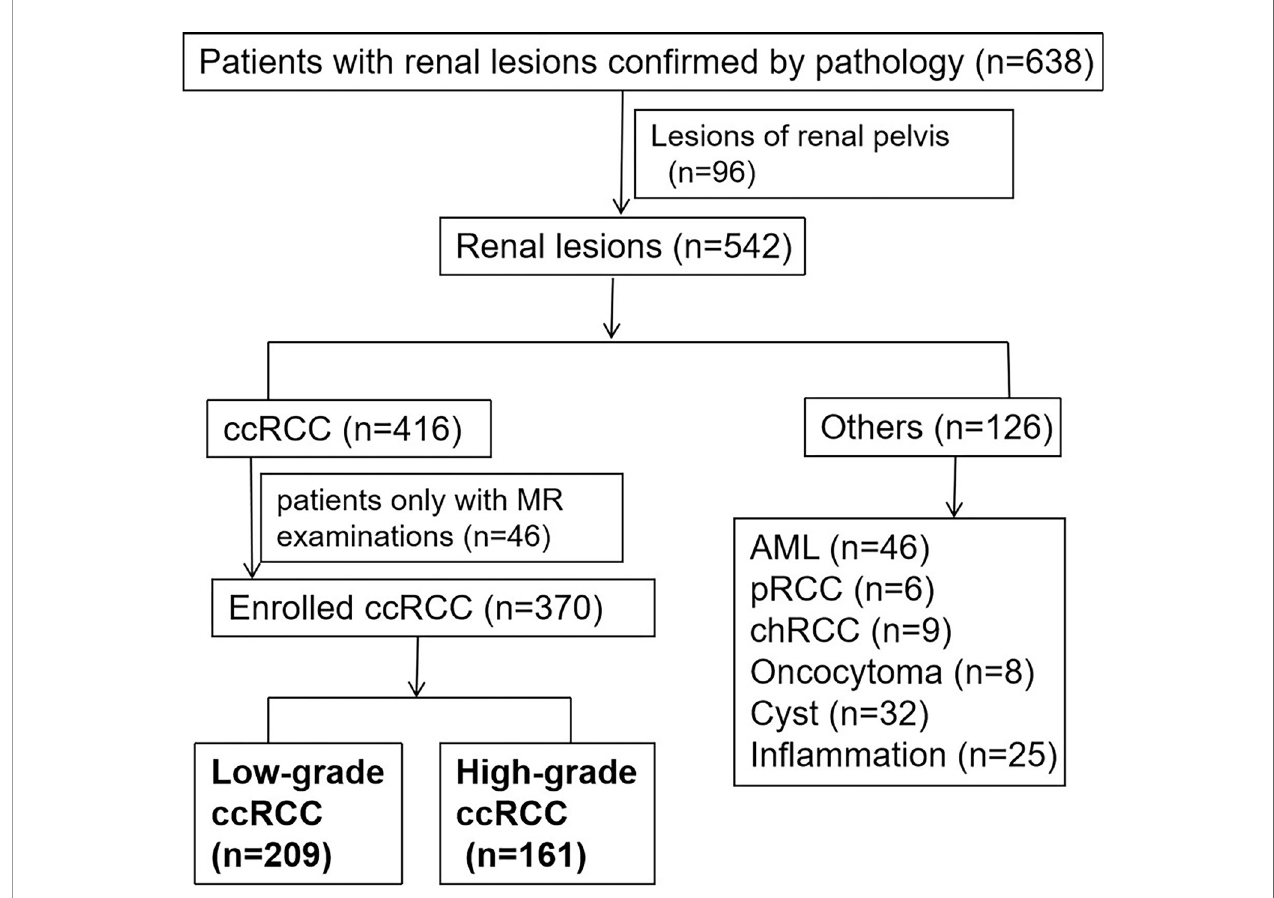
FIGURE 1 | The fl owchart of patient enrolment. Finally, there were 209 low-grade patients and 161 high-grade patients